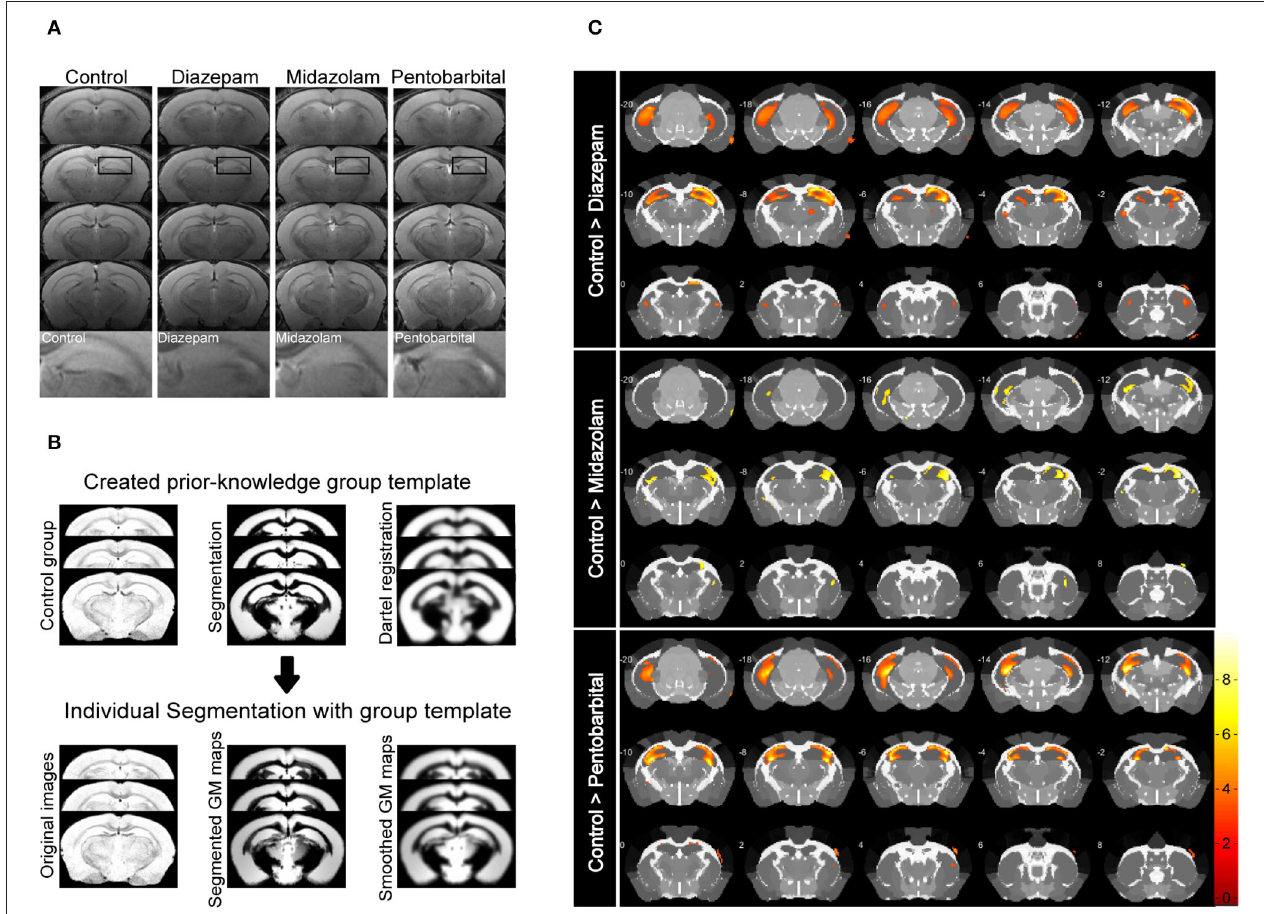
FIGURE 3 | Voxel-based morphometry (VBM) analysis of MRI T2-weighted images showing differential hippocampal atrophy 9 weeks after SE received different treatments. (A) Hippocampal T2 maps along the rostro-caudal axis (up-down) showing sclerotic atrophy of hippocampus of control (non-SE and no treatment), diazepam, midazolam, and pentobarbital groups of mice after SE. The images in the lowest row are the amplifications of areas in the rectangle of the second row of images. (B) The template creation for spatial normalization of the segmented gray matter (GM) images and VBM procedure. (C) Each subfigure of the treatment group showed volumetric changes of GM when compared with corresponding subfigure of control group. Hippocampal GM densities in the midazolam group were significantly higher than other groups. The color scale bar on the right represents t-value of the statistical analysis. Control n = 6; diazepam n = 7; midazolam n = 7; and pentobarbital n =